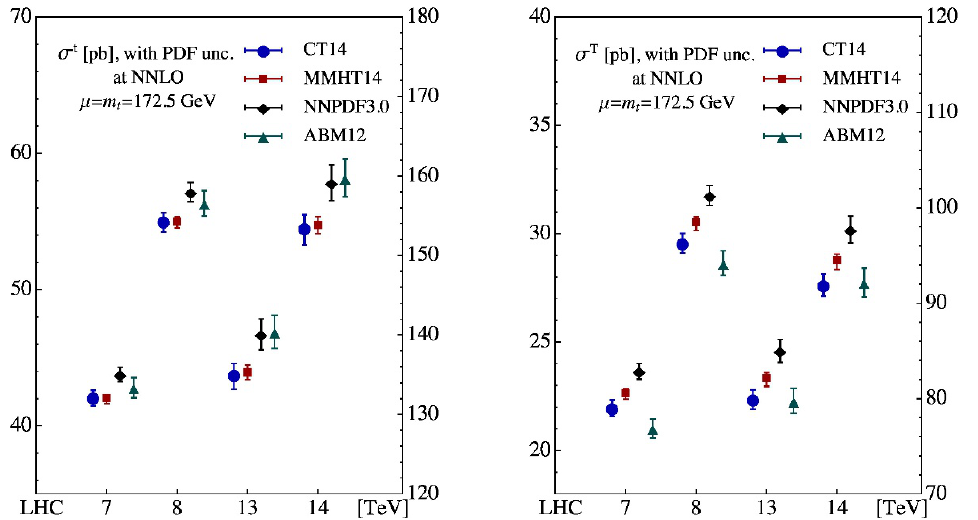
Figure 16 . Inclusive cross sections for t -channel single top quark (left) and anti-quark (right) production at NNLO with various NNLO PDFs, for the LHC with di(cid:11)erent center of mass energies. Error bars represent 1 (cid:27) PDF